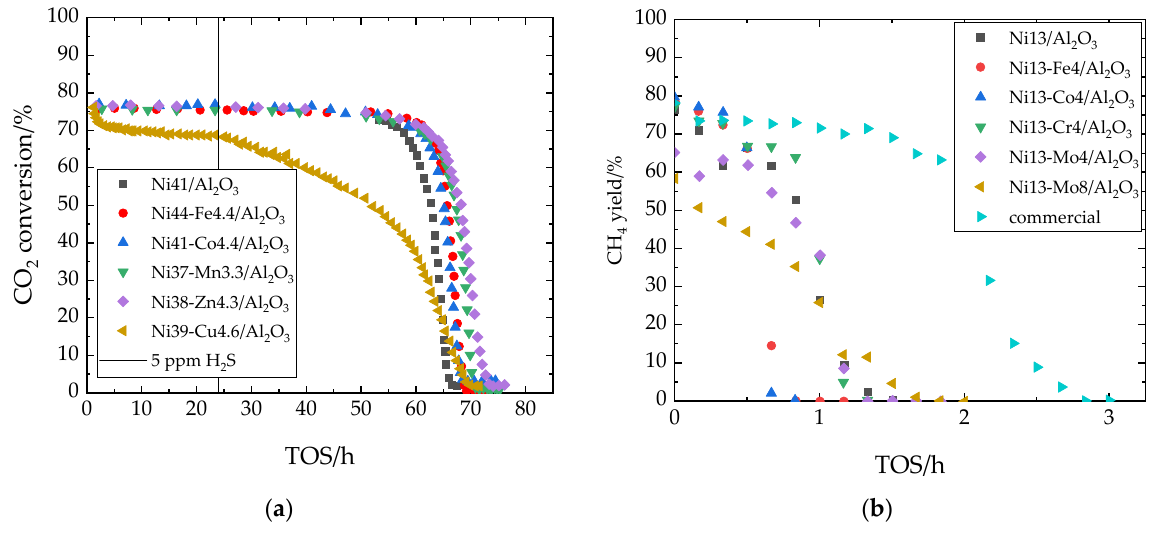
Figure 7. CO 2 conversion or CH 4 yield in H 2 S poisoning experiments in methanation with Ni/Al 2 O 3 catalysts and transition metal promoters with ( a ) 5 ppm H 2 S addition after 24 h [41] and ( b ) 50 ppm H 2 S addition [64].